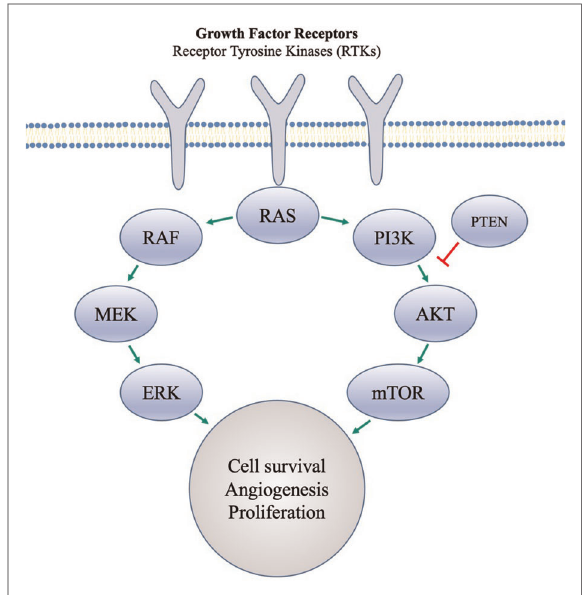
FIGURE 3 Tyrosine kinase receptors involved in angiogenesis and cell proliferation. Obesity promotes proangiogenic factors that act at the receptor level. Cancer cells that are able to evade hormonal